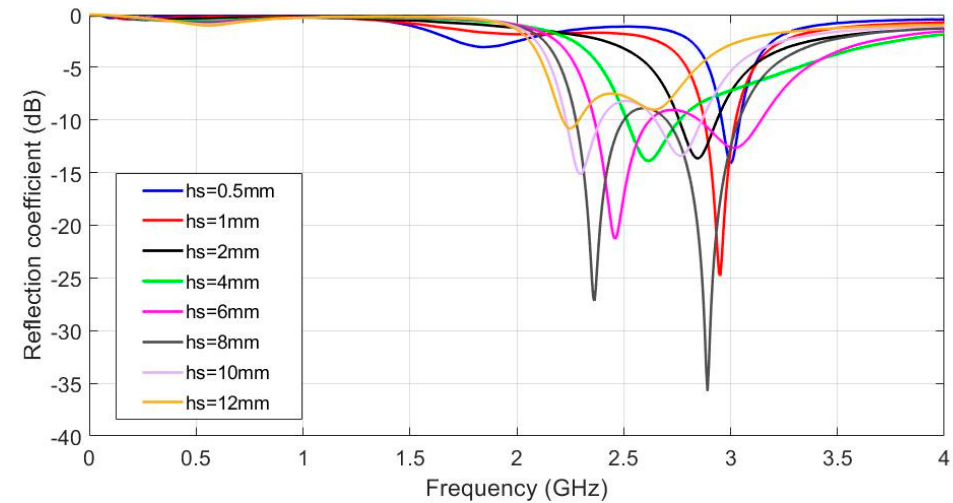
Figure 4. Simulated reflection coefficient for the different substrate thickness values, h S from 0.5 mm to 12 mm, h C = 0.1 mm, ε r = 1.3 and tan δ = 0.058.